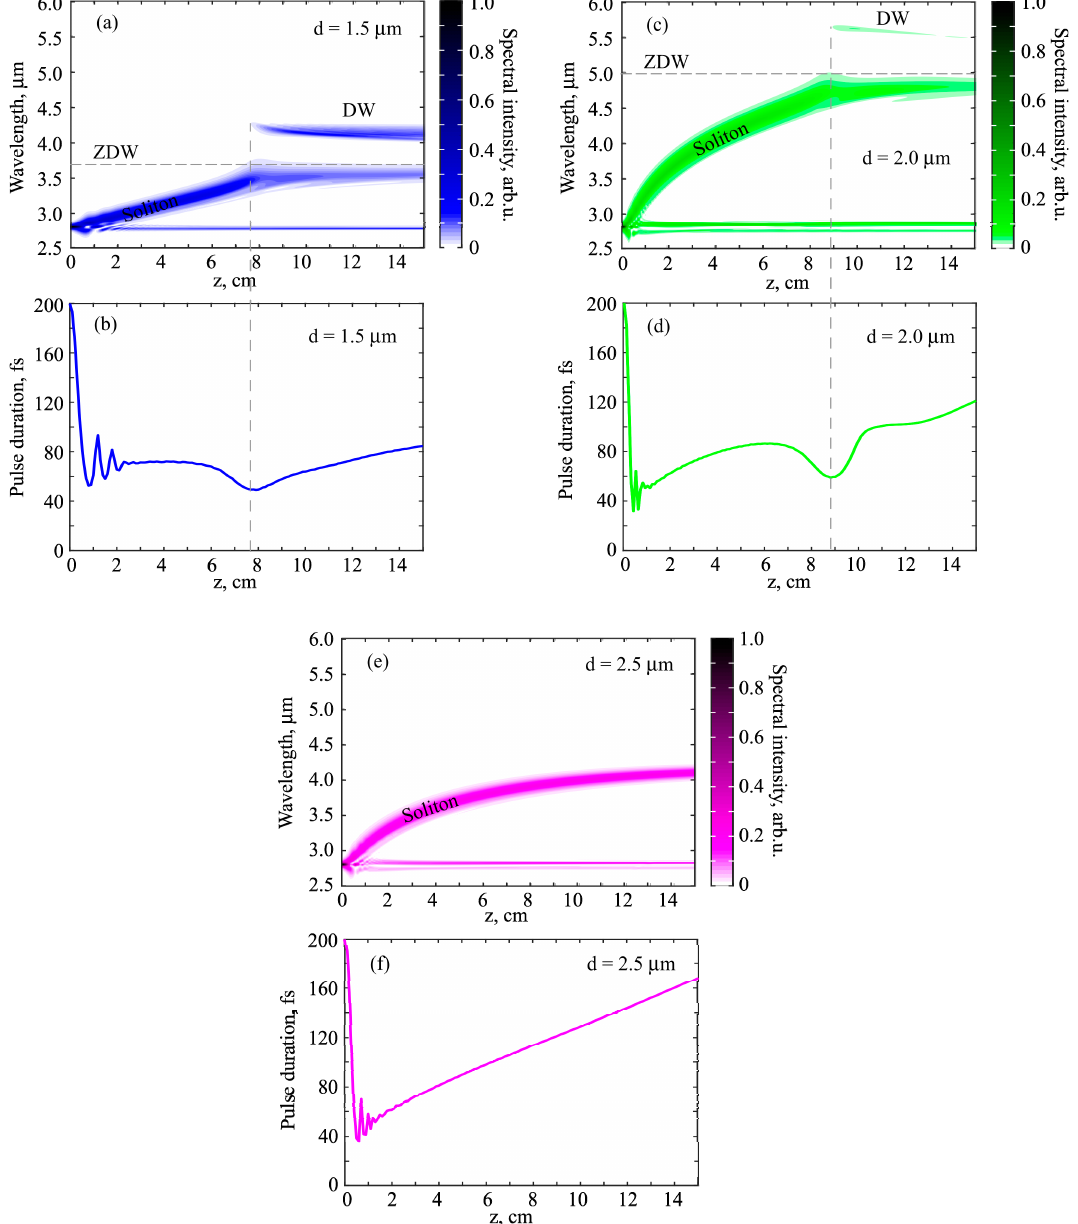
Figure 7. Evolution of spectral intensity and pulse duration of initial 200-fs sech 2 -shape signal during propagation in MS fibers for d = 1.5 μ m ( a ) ( b ), respectively; for d = 2 μ m ( c ) ( d ), respectively; and for d = 2.5 μ m ( e ) ( f ), respectively. Initial pulse energy is 500 pJ for d = 2 μ m and d = 2.5 μ m and 150 pJ for d = 1.5 μ m.